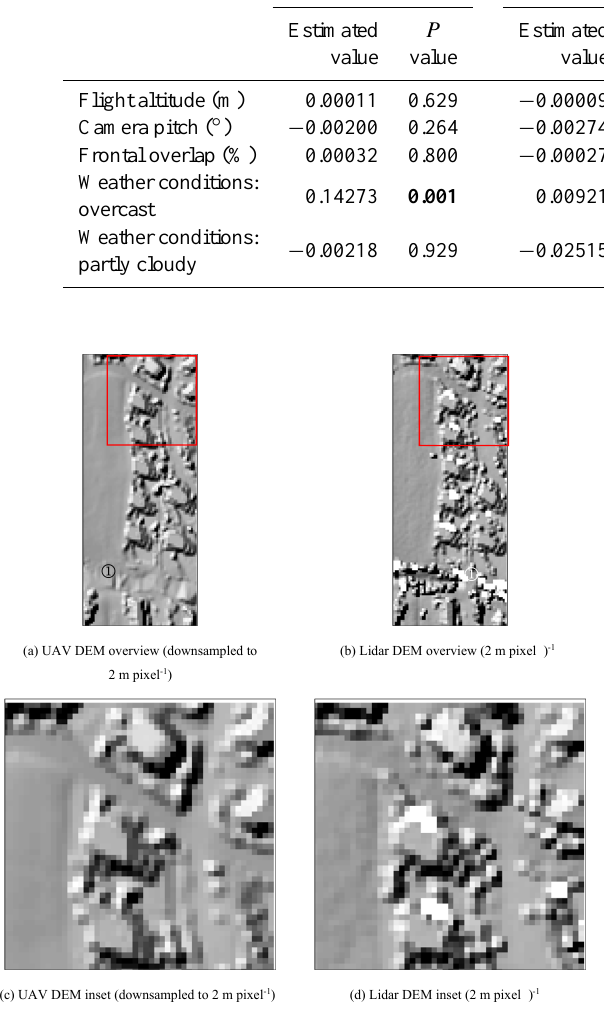
Figure 6. Visual comparison of the UAV DEM and lidar